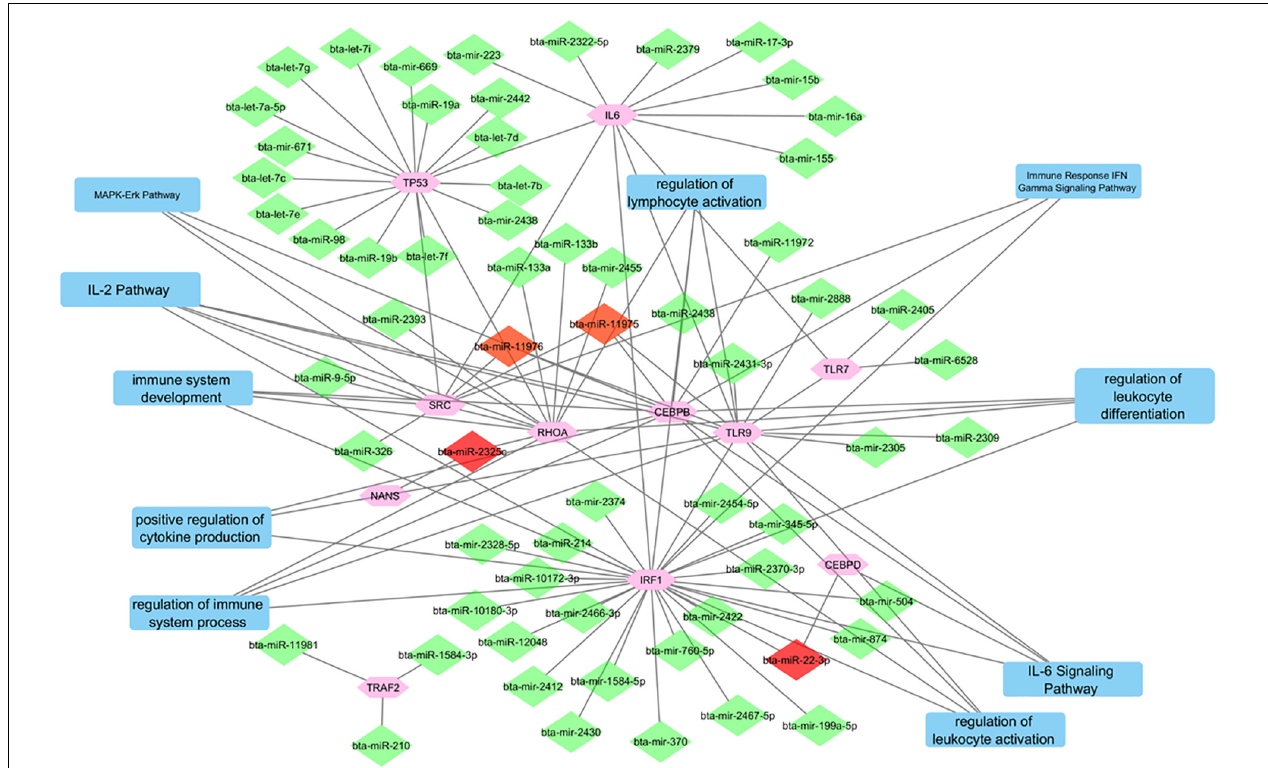
FIGURE 4 | A network incorporating the identified genes, the miRNAs that target them, the interactions between them, and the pathways that they are indicated in.